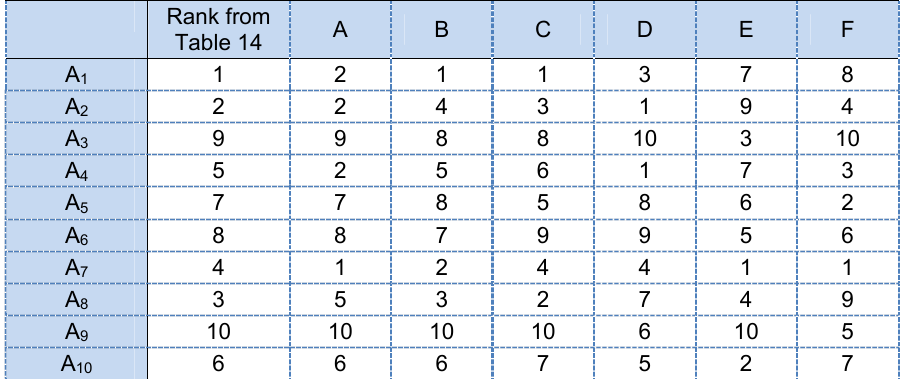
Table 16 – Ranks of alternatives by the application of different situations Таблица 16 – Рейтинги альтернатив при применении различных сценариев Tabela 16 – Rangovi alternativa primenom razli č itih scenarija Rank